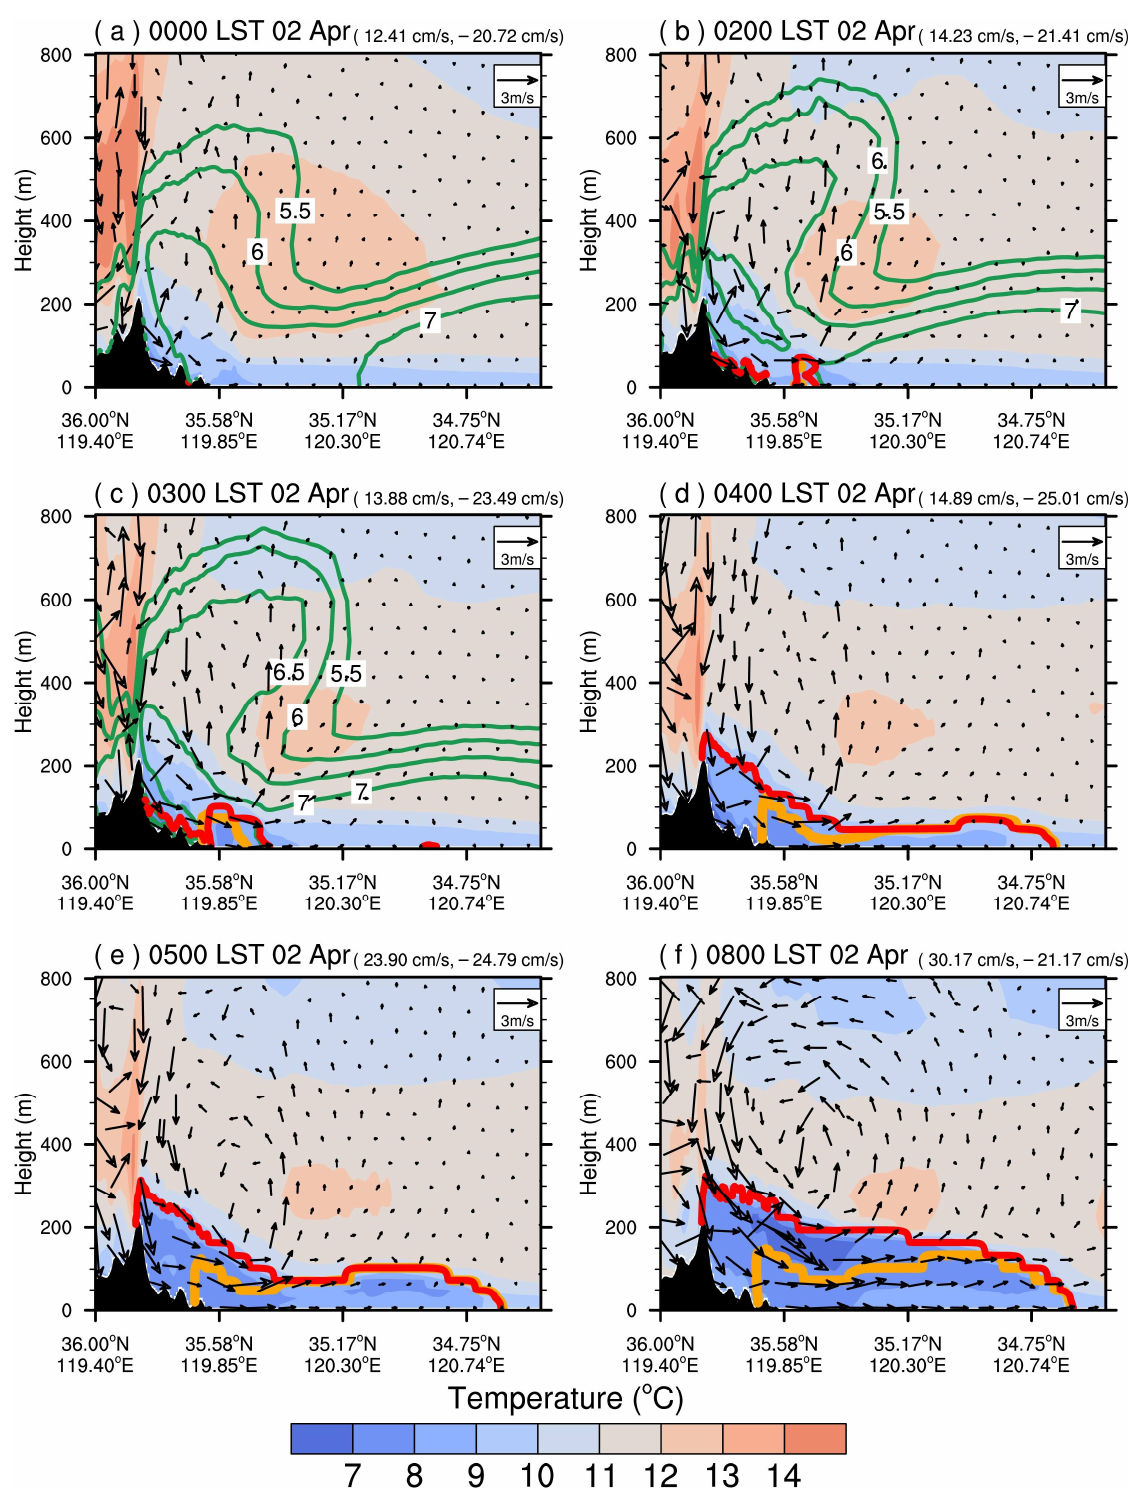
Figure 8. Evolution of the land breeze circulation (vectors), mixing ratio (green lines), and sea fog in the vertical cross-section along the line A–B marked in Figure 1. Temperatures of Exp-Ctrl are shown by color shades. Sea fog vertical extents of Exp-Ctrl and Exp-LB0 are outlined by the coarse lines colored in red and orange, respectively. The information of time and maximal vertical velocities are shown at the top of the panels ( a – f ).